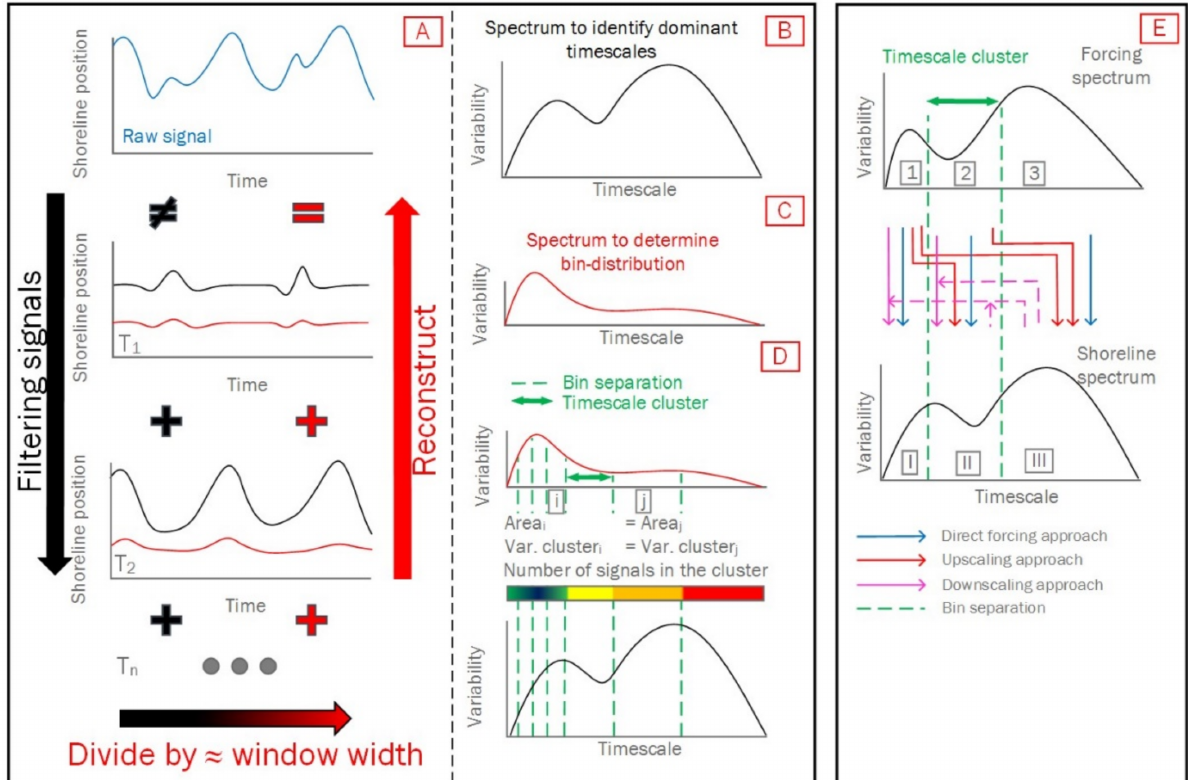
Figure 2. Multi-timescale implementation within SF-ST. ( A ) Schematic overview of the filtering and reconstruction method of the raw (either shoreline or wave) signal (blue timeseries). Due to filtering, multiple signals emerge with different timescales ( T 1 , T 2 , T n ; black timeseries). By dividing each filtered signal by a value which is proportional to the window width of the filter function, the linear superposition of the resulting timeseries (red) does yield the raw signal. Subsequently, two spectra are constructed: one is used to identify dominant timescales (black, ( B ), the other is used to construct timescale clusters (red, ( C )). ( D ) shows an example of how bins (i.e., bands) are distributed and how corresponding timescale clusters are formed. The linear superposition of all filtered signals in a bin (in between two green vertical lines), result in one timescale cluster. The color-bar shows the number of filtered signals within a cluster, which is related to the variability of the filtered signals: the higher the variability, the lower the number of filtered signals in a bin, such that the total variability within a bin is constant. ( E ) shows a schematic overview of the multi-timescale implementation in SF-ST using synthetic spectra. The signals corresponding to a timescale cluster in the wave forcing ( H s , T p , indicated with 1, 2 and 3) and shoreline spectrum (indicated with I, II and III) are related in three ways: through direct forcing, upscaling and